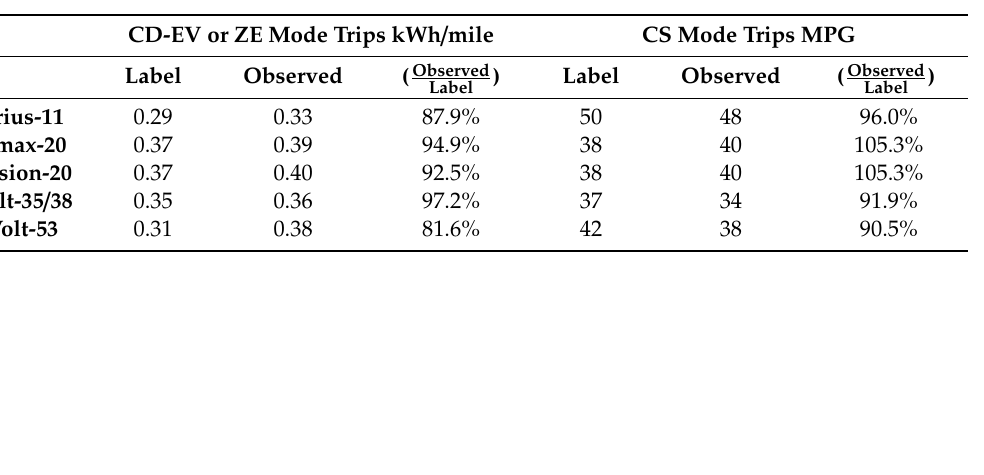
Table 3. Comparison of label expected and observed ZE and CS mode energy consumption.